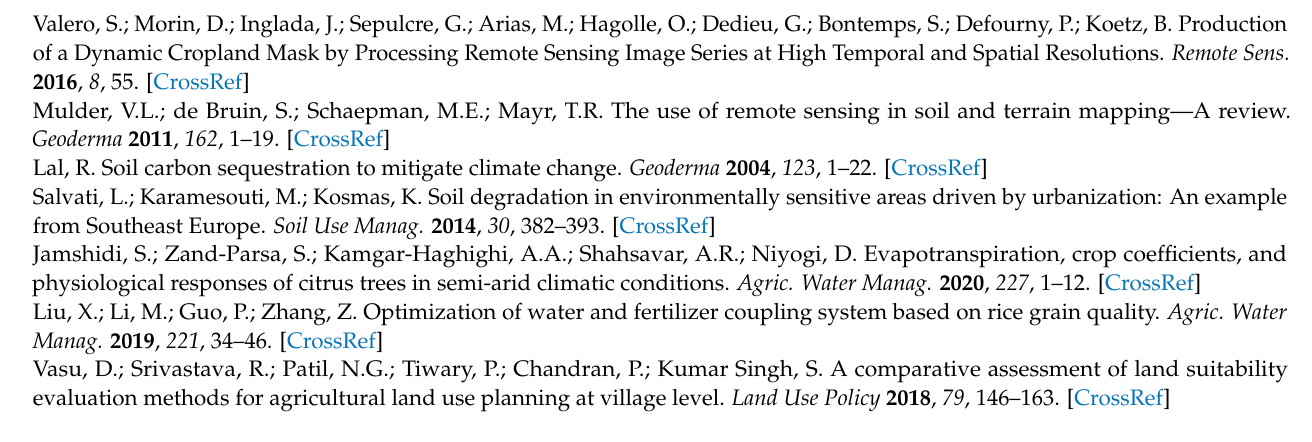
Figure S3: Yearly Bare Soil Frequency of the Ferrara region for the agricultural year 2018, Figure S4: Yearly Bare Soil Frequency of the Ferrara region for the agricultural year 2019, Figure S5: Yearly Bare Soil Frequency of the Rome region for the agricultural year 2016, Figure S6: Yearly Bare Soil Frequency of the Rome region for the agricultural year 2017, Figure S7: Yearly Bare Soil Frequency of the Rome region for the agricultural year 2018, Figure S8: Yearly Bare Soil Frequency of the Rome region for the agricultural year 2019, Figure S9: Yearly Bare Soil Frequency of the Capitanata region for the agricultural year 2016, Figure S10: Yearly Bare Soil Frequency of the Capitanata region for the agricultural year 2017, Figure S11: Yearly Bare Soil Frequency of the Capitanata region for the agricultural year 2018, Figure S12: Yearly Bare Soil Frequency of the Capitanata region for the agricultural year 2019, Table S1: Percentage of pixels of bare soil frequency classes for the monthly- average over the four-years of Ferrara region, Table S2: Percentage of pixels of bare soil frequency classes for the monthly-average over the four-years of Rome region, Table S3: Percentage of pixels of bare soil frequency classes for the monthly-average over the four-years of Capitanata